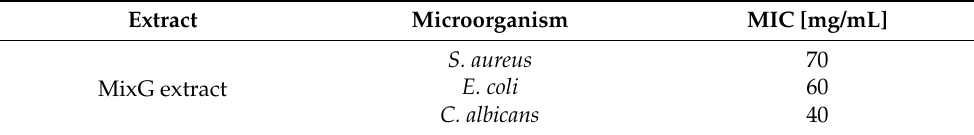
Table 3. Determined MIC values for testing the antimicrobial activity of mixG extract on the growth of the tested microorganisms ( E. coli , S. aureus and C. albicans ) using the microdilution method. MIC values correspond to the minimum extract concentrations that inhibit the growth of microbial cells, expressed in mg/mL. Extract Microorganism MIC [mg/mL] S. aureus 70 E. coli 60 MixG extract C. albicans